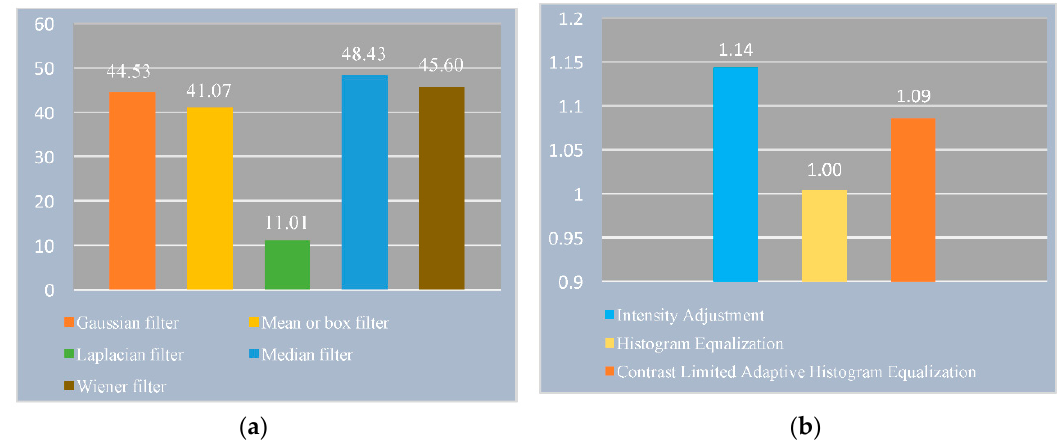
Figure 4. Image quality assessment metrics: ( a ) peak signal to noise ratio (PSNR) comparison for filtering methods, and ( b ) contrast improvement index (CII) comparison for contrast enhancement methods.